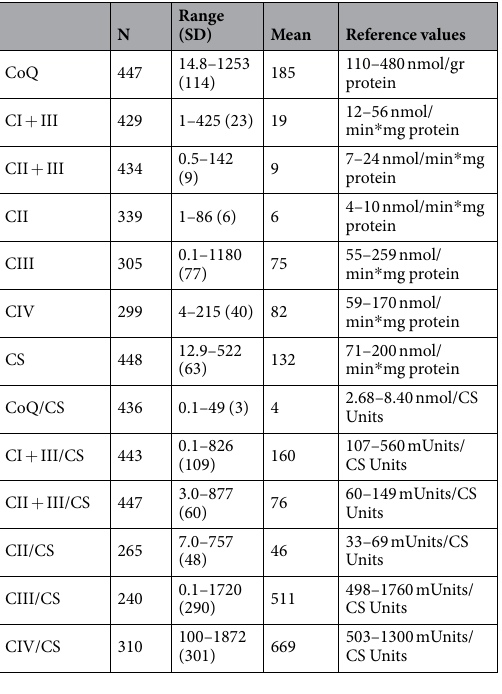
Table 1. Biochemical data from the whole cohort of patients. The range, standard deviation (SD) and mean of CoQ and MRC activities is given, expressed either by protein content or CS units. Reference values are also stated.